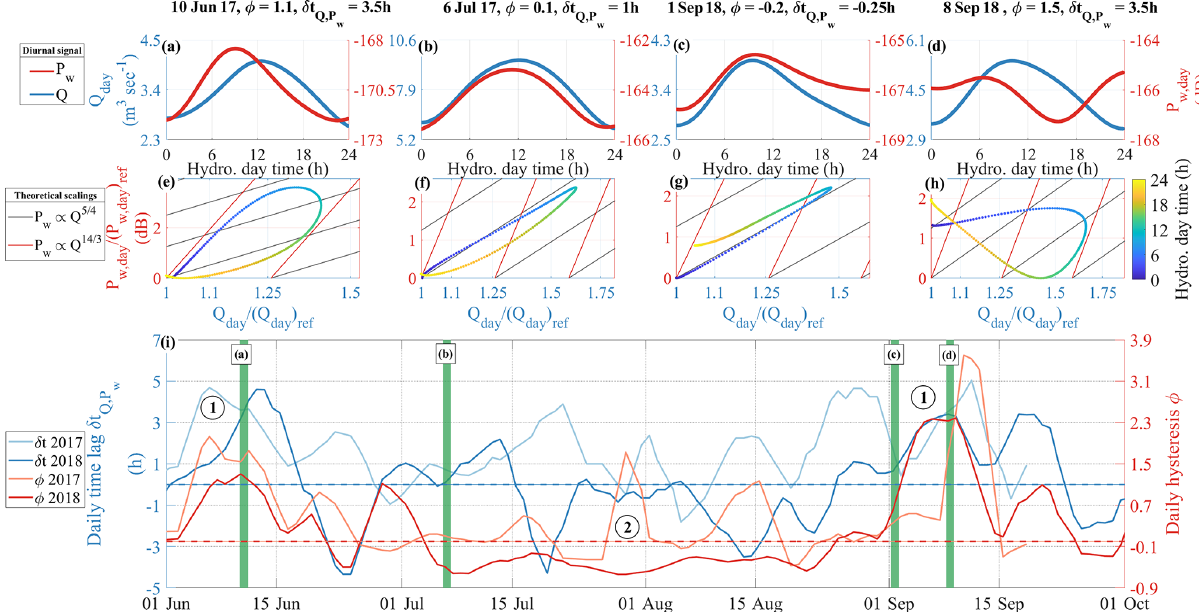
Figure 7. Diurnal observations of the subglacial channel-flow-induced seismic power P w and water discharge Q and comparison with predictions from Gimbert et al. (2016). (a–d) Daily evolution of the 6–36h bandpass-filtered seismic power P w , day (red line) and water discharge Q day (blue line) for 4 selected hydrological days. Values of P w , day and Q day are centred on the average respective absolute value of the corresponding day. Corresponding values of daily δt Q,P and φ are shown at the top of the panels. (e–h) Observed (coloured dots) w and predicted (red and black lines calculated with Eqs. 6 and 7) P w -versus- Q daily relationships. Note that y axis bounds differ from panel to panel. Both variables are normalized by their daily minima. (i) Daily time lag δt Q,P between P w , day and Q day peaks (blue lines) and w daily hysteresis φ between P w , day and Q day (red lines). Shaded lines are data from 2017, and plain ones are data from 2018. Dashed lines = 0 (blue) and φ = 0 (red). Time series are smoothed over 5d. Green vertical bars show times of the 4 selected hydrological show δt Q,P w days with the corresponding panel number. Circled numbers refer to the two phases described in the main